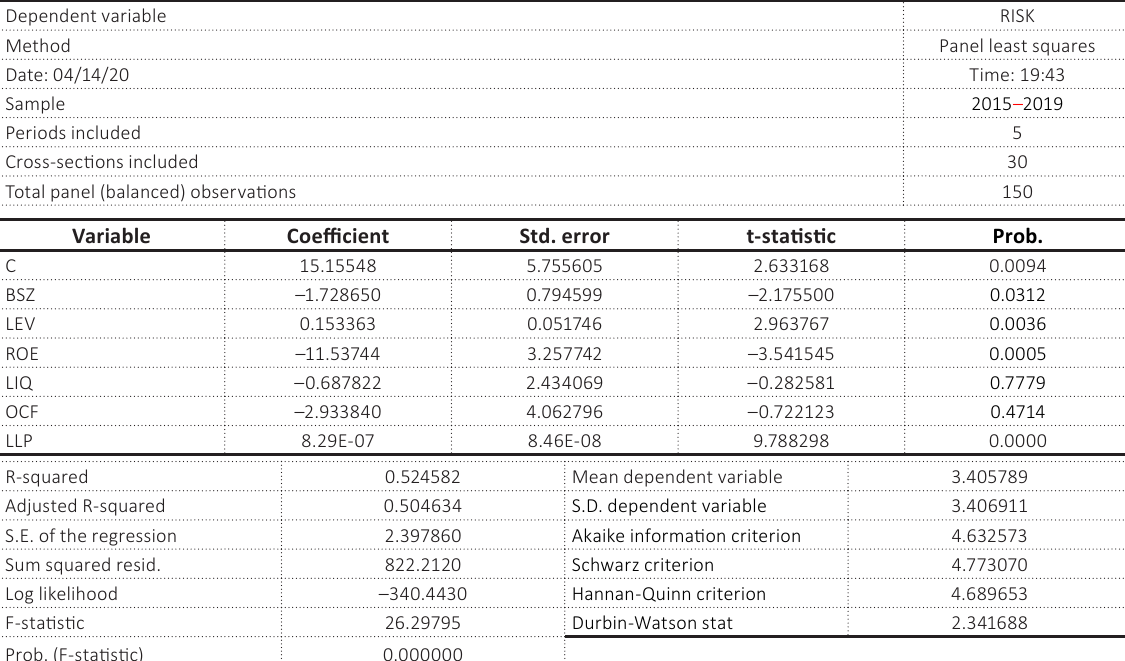
Table B2. Regression results and overall significance of the